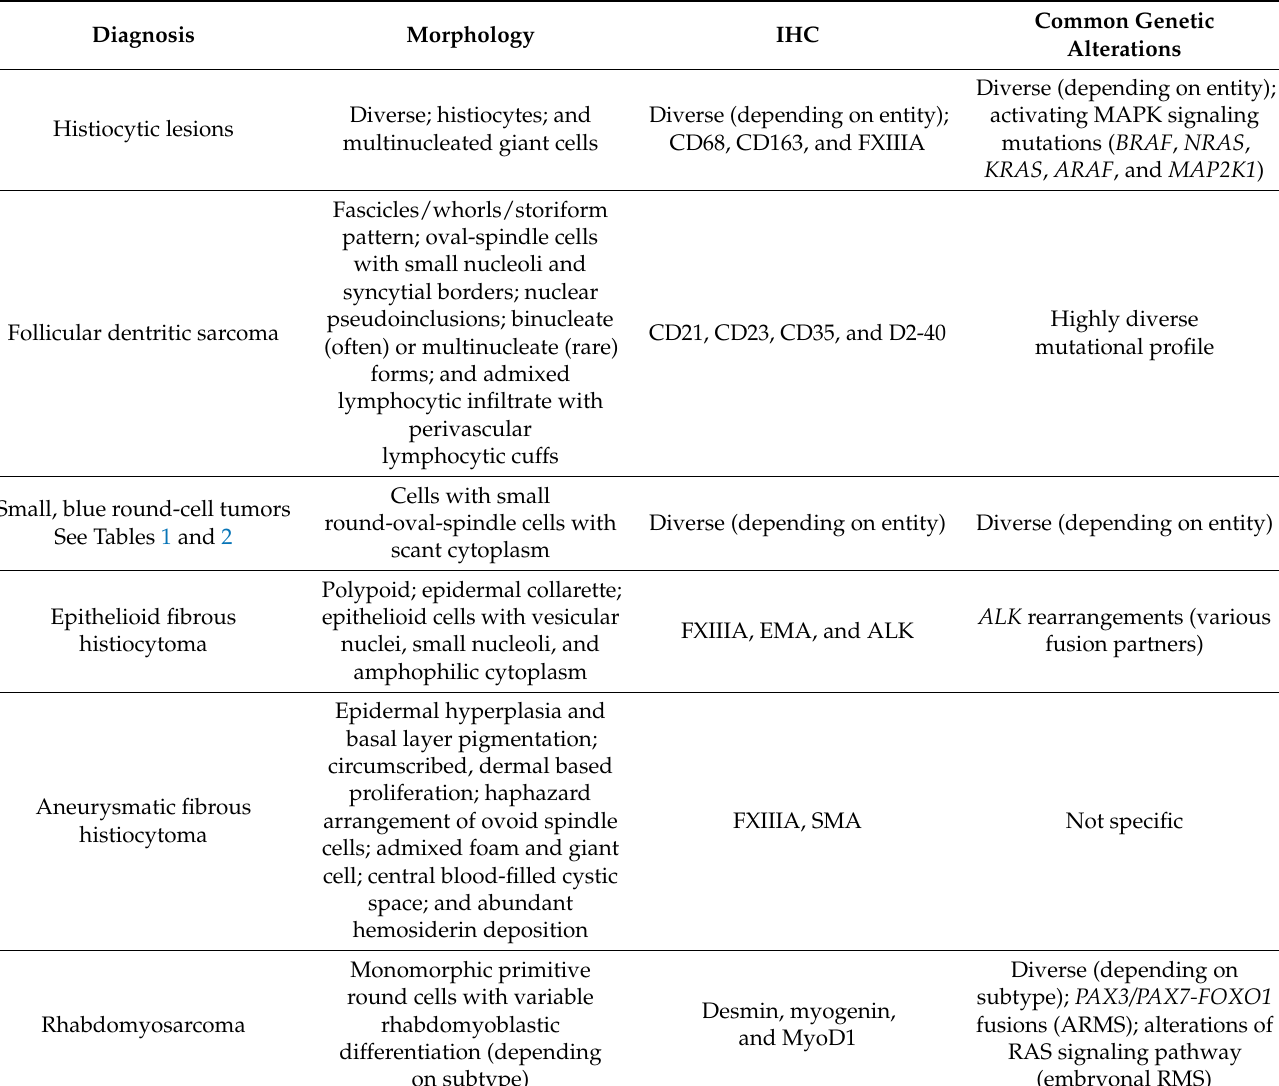
Figure 6. Angiomatoid fibrous histiocytoma showing sheets and short fascicles of histiocytoid cells with monomorphic nuclei. Note the lymphocytic reaction (HE; 20 × magnification). Table 5. Differential diagnoses of